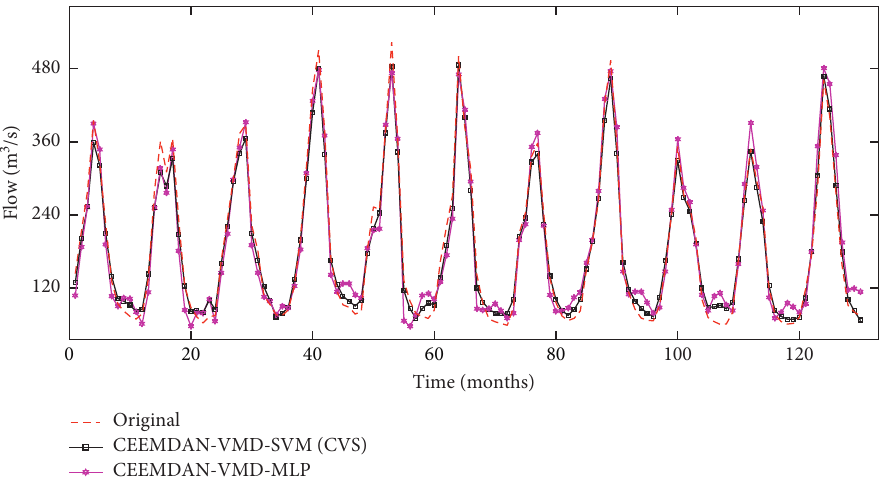
Figure 10: Observed and predicted runoff during the model testing period using CVS and CEEMDAN-VMD-MLP